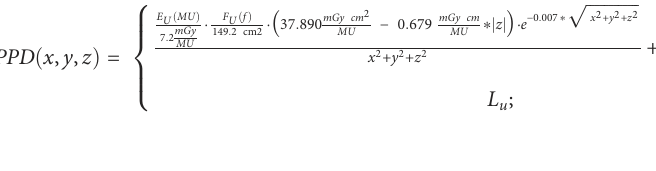
(cid:3) EU MU ð Þ · FU ð f Þ 149 : 2 cm2 · 37 : 890 mGy cm 2 MU − 0 : 679 mGy cm MU ∗ z j j 7 : 2 mGy MU